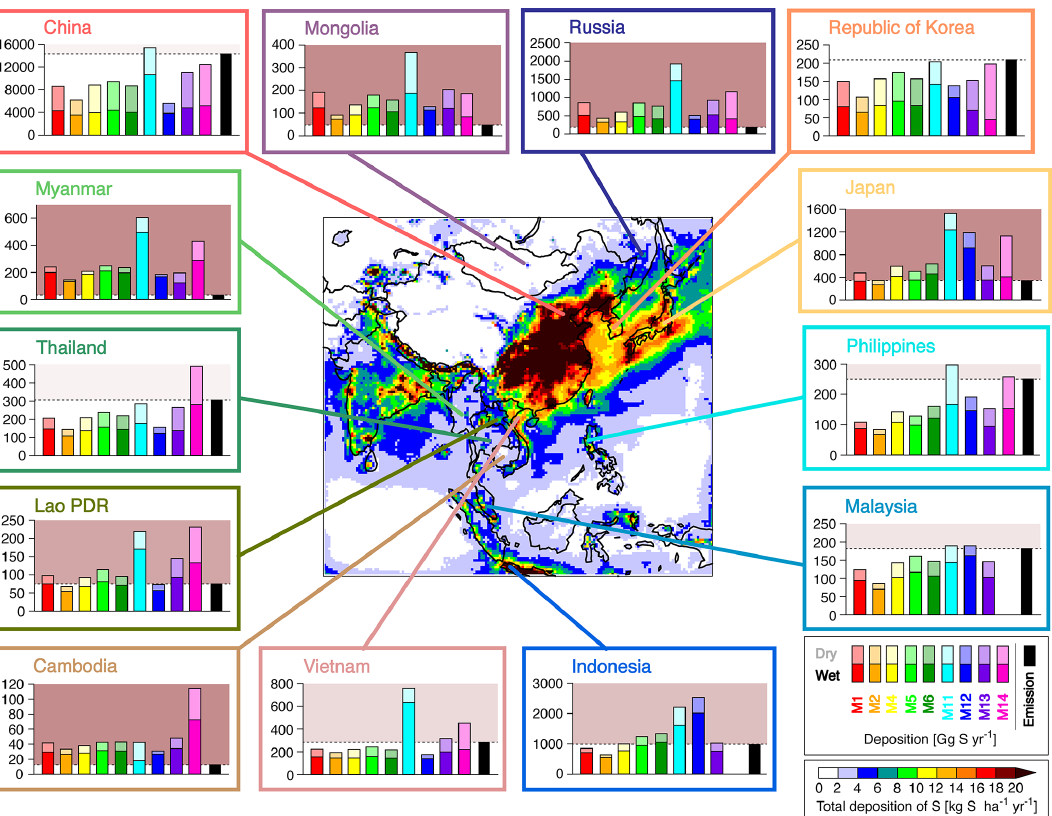
Figure 9. Map of the annual accumulated total S deposition over Asia. The cumulative bar graphs show dry deposition (light colors) and wet deposition (dark colors), with different colors representing different models and black representing the amount of anthropogenic SO 2 emissions. The background red areas of the graphs indicate an excess of total deposition compared to emissions, and their transparency is based on the number of models making this prediction (i.e., bolder colors indicate that more of the nine models simulated the excess).